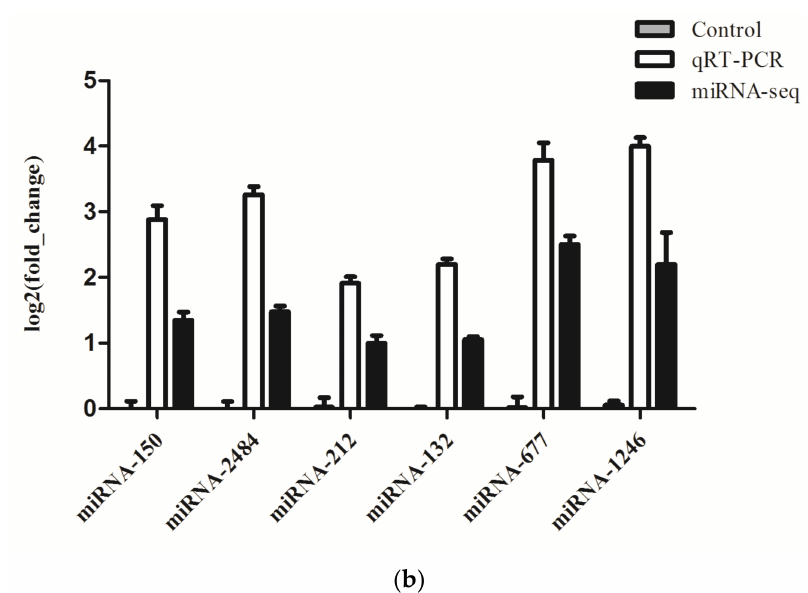
Figure 1. ( a ) Scatter plots showing the di ff erentially expressed miRNAs in MDMs challenged with MAP compared to the control MDMs. Red, blue and gray are representative the upregulated, downregulated and unchanged miRNAs, respectively.; ( b ) Validation of the RT-qPCR analysis of bta-miR-677, bta-miR-132, bta-miR-1246, bta-miR-150, bta-miR-212 and